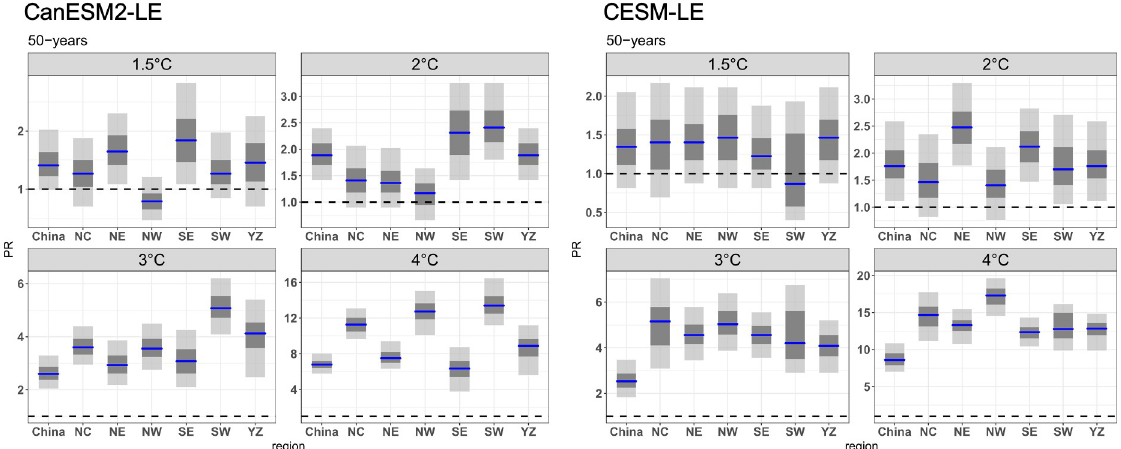
Fig 8. The risk ratio of CDHEs in 50 years under different warming scenarios. The blue line represents the risk ratio, and the grey indicates the confidence interval range obtained based on 1000 bootstrap samples. The dark grey demonstrates the 95% confidence level, and the light grey demonstrate the 90% confidence level. we have added in the revised manuscript.